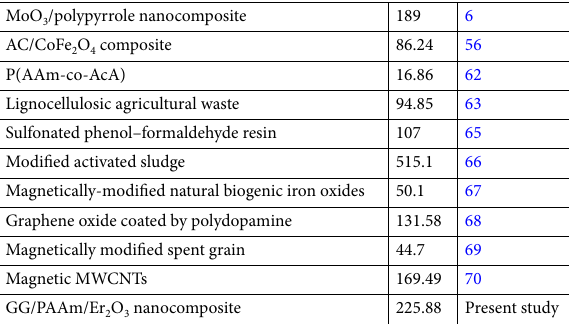
Table 2. Comparison of Q m (mg/g) values with other available adsorbents for nile blue removal.